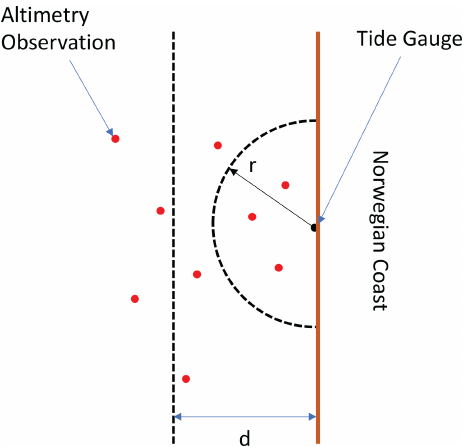
Figure 3. Sketch to illustrate the procedure used to build a monthly averaged SLA time series from the ALES-reprocessed satellite al- timetry dataset at each tide-gauge location. The parameter r is the distance from the tide gauge, whereas d is the distance from the